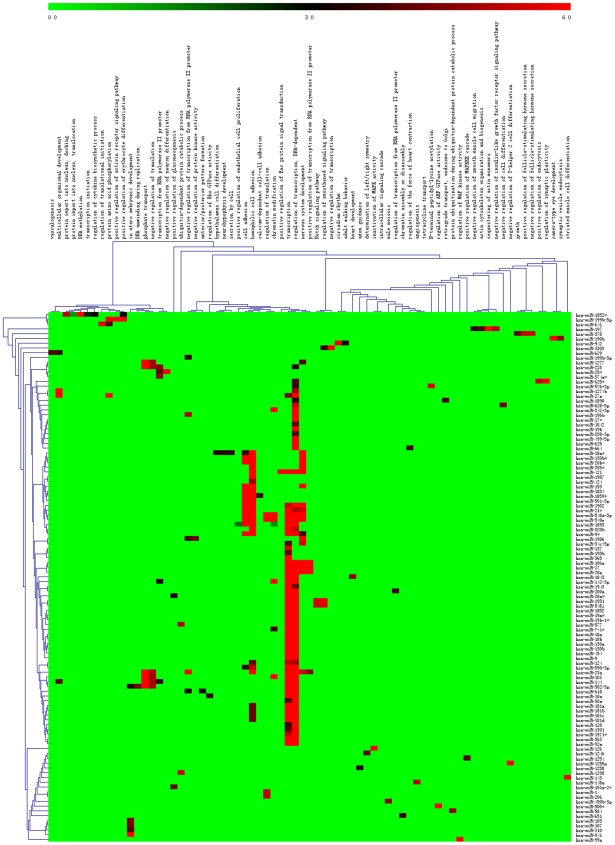
Clustering of over-represented Gene Ontology (GO) classes in predicted targets of differential microRNAs (fold changes>2.0 and P-value of <0.001).All genes with statistically over-represented GO annotations were included (P<0.001).